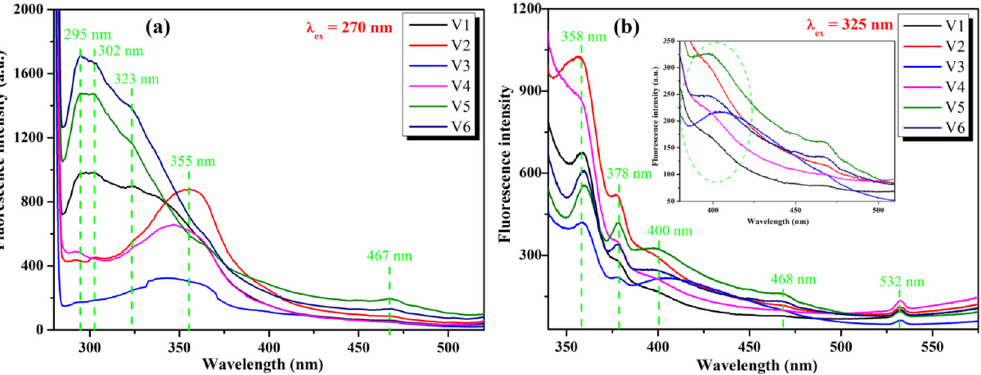
Figure 10. Fluorescence spectra of pristine CeO 2 NPs (V1–V6) at λ ex = 270 nm ( a ) and λ ex = 325 nm ( b ). The fluorescence intensity of Co-doped CeO 2 NPs, V2-Co and V5-Co, is lower than that of the pristine V2 and V5 at both excitation wavelengths λ ex = 270 nm (Figure 11a) and λ ex = 325 nm (Figure 11b). The reduction in fluorescence intensity by the Co-doping of CeO 2 NPs shows that the charge recombination rate was diminished to the desired point in order to enhance the photocatalytic performance.